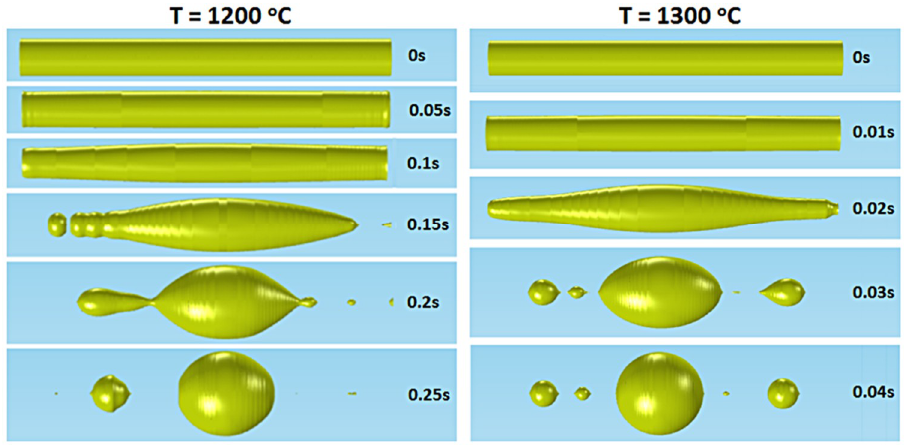
Figure 4. Different stages of the Plateau-Rayleigh instability during static heating for different temperatures (1200 °C and 1300 °C) of a gold cylindrical rod by inserting a surface tension perturbation.